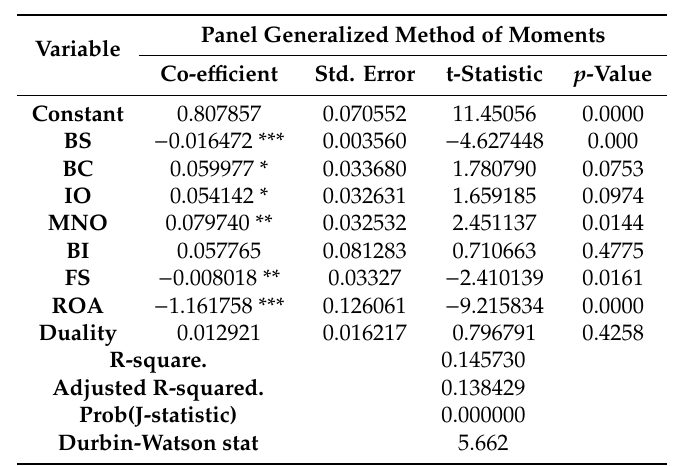
Table 4. Panel Generalized Method of